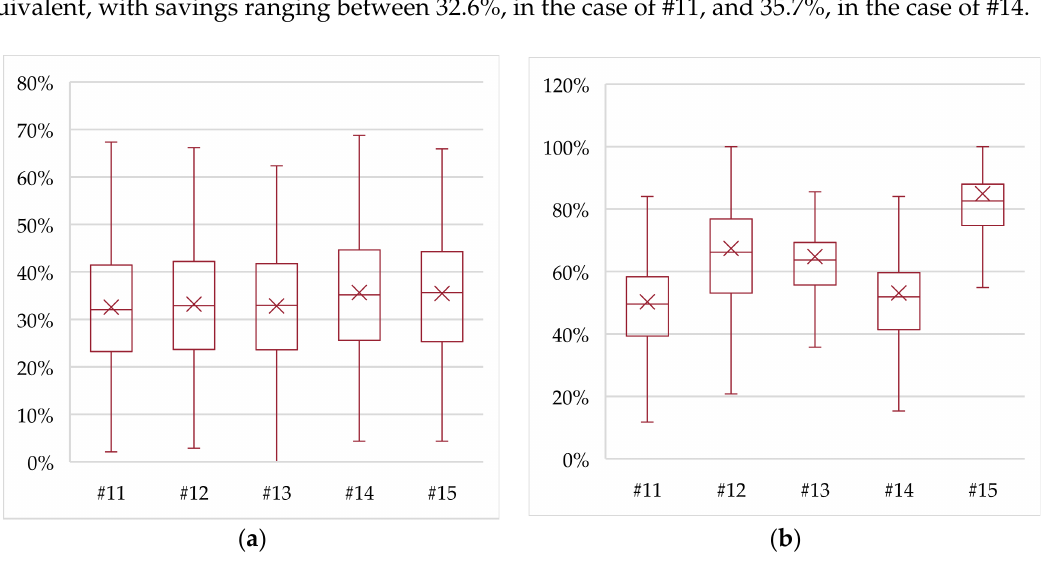
Figure 10. Resulted savings of ( a ) primary energy consumption; ( b ) local emissions.